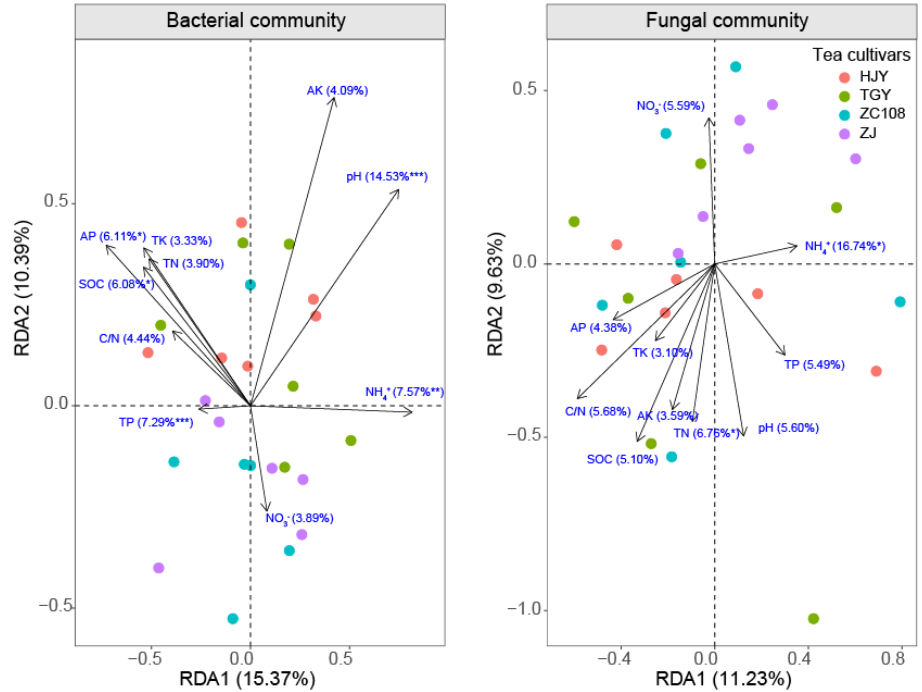
Figure 6. Redundancy analysis (RDA) shows the relationship between bacterial (left panel) and fungal (right panel) community composition and soil properties. The values in brackets represent the explained variation of each soil property in bacterial and fungal community composition. The significance level is indicated by * ( p < 0.05) ,** ( p < 0.01) and ***( p < 0.001) by using a permutational multivariate analysis of variance (PERMANOVA). HJY, Huangjinya, TGY, Tieguanyin, ZC108, Zhongcha108, ZJ, Zijuan.